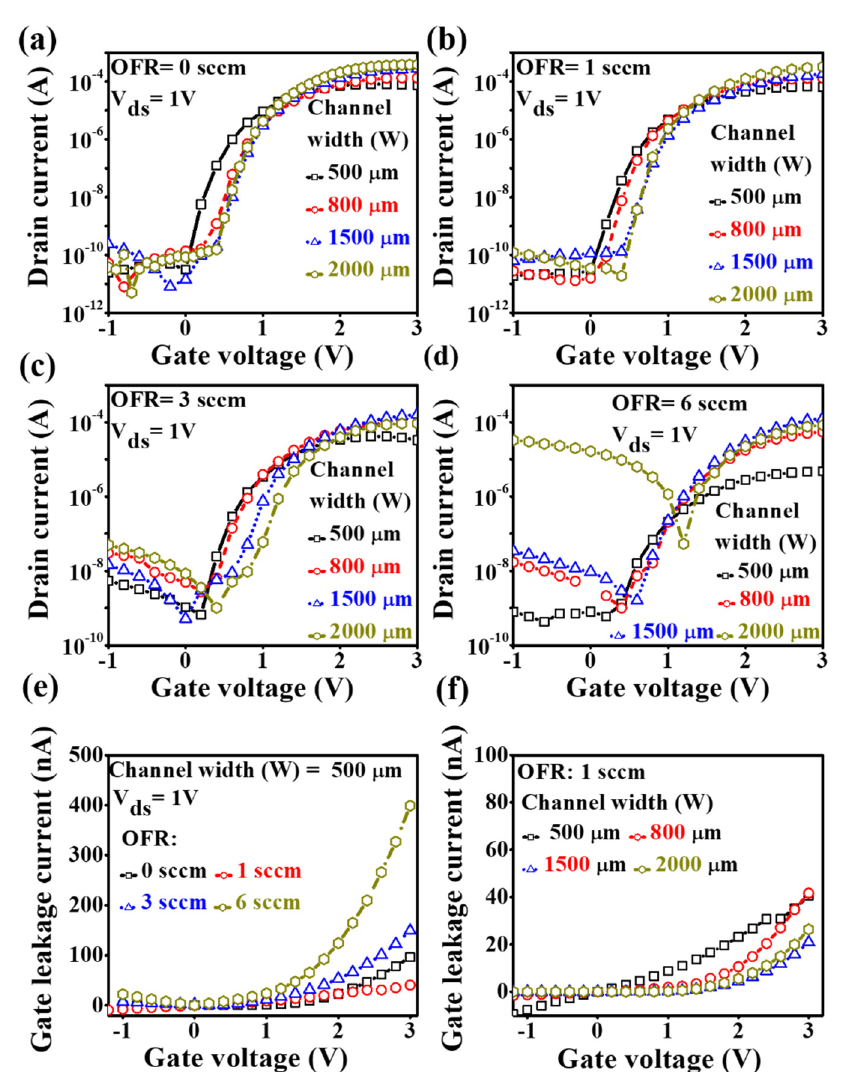
Figure 7. Typical transfer characteristics of a -IGZO based TFT with oxygen flow rate of ( a ) 0 sccm, ( b ) 1 sccm, ( c ) 3 sccm and ( d ) 6 sccm. The fixed drain voltage is 1 V, gate voltage sweeping from − 1 V to + 3 V (the open square with solid line, open circle with dash line, open triangle with dot and open hexagon with dash–dot line represent the transfer characteristics for channel width 500 µ m, 800 µ m, 1500 µ m and 2000 µ m, respectively). The effects of ( e ) OFR and ( f ) channel width (W) on gate leakage current are presented. Table 2. The electrical performance parameters of a -IGZO TFT with different sizes of channel width at an oxygen flow rate of 0 sccm.